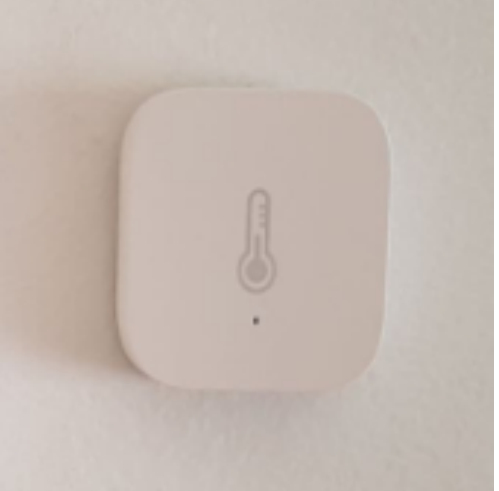
Figure 21. Temperature and humidity sensor to monitor comfort in a room.